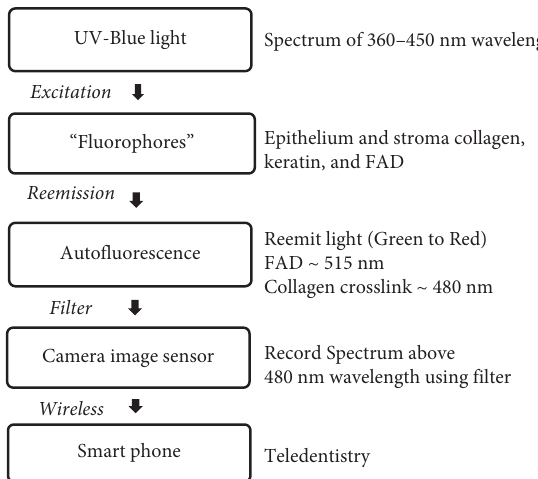
Figure 3: Devices mechanism for autofluorescent